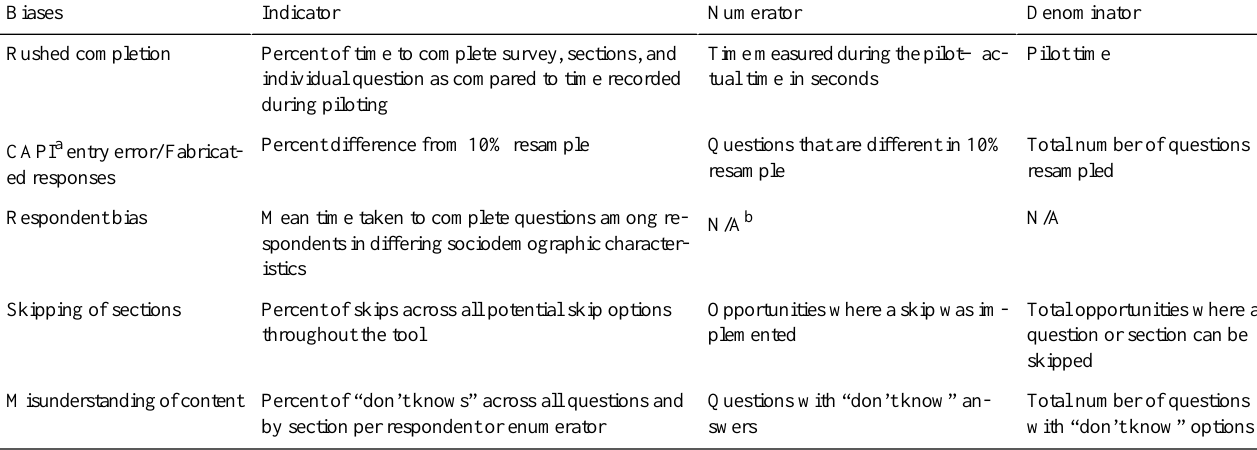
Pilot timeTime measured during the pilot—ac- tual time in